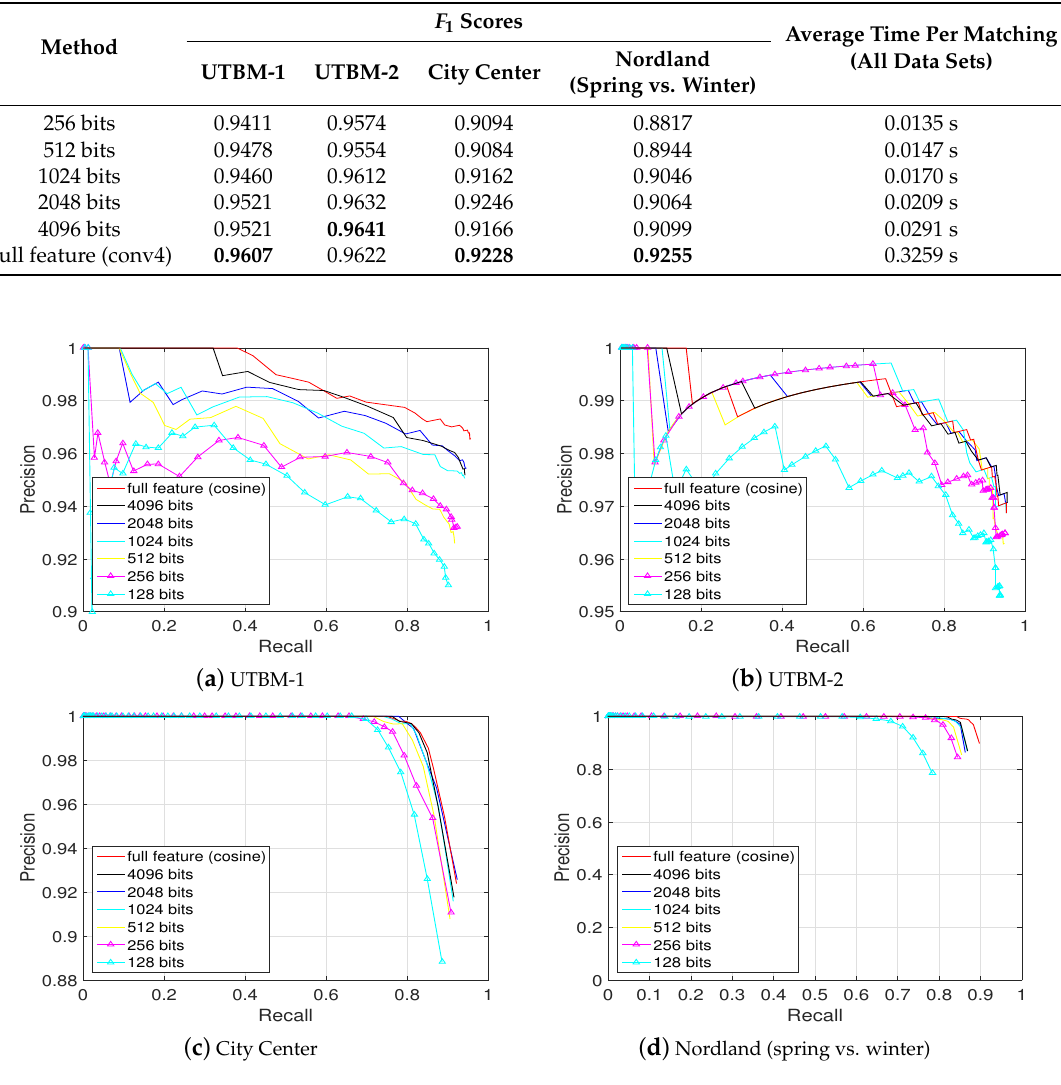
Figure 15. Precision-recall curves of different hash bit lengths. The cosine distance over the full feature vector of 64,896 dimensions (red) can be closely approximated by the hamming distance over bit vectors of length 4096 (dark) without losing much performance. This corresponds to a compression of